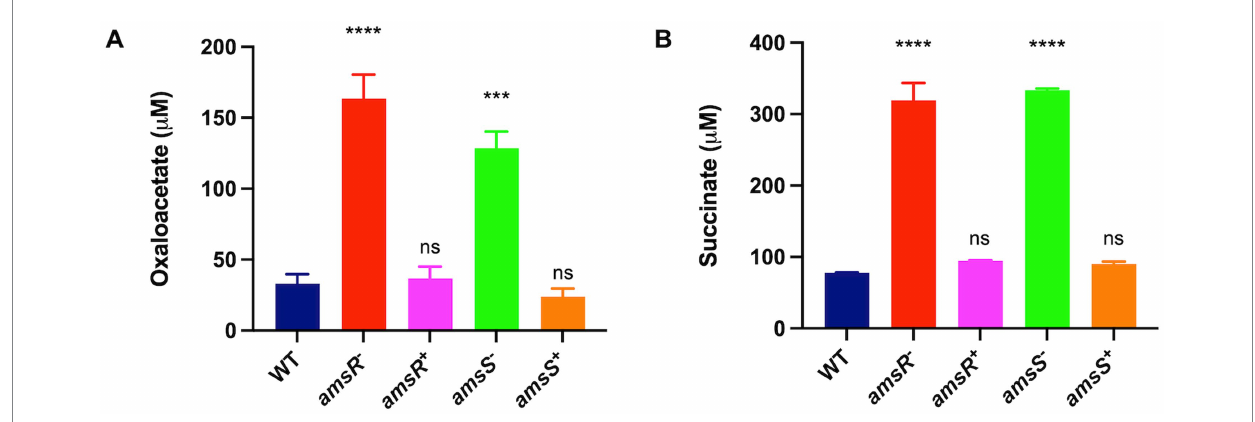
FIGURE 8 Oxaloacetate and succinate accumulate in amsSR mutants due to impaired TCA cycle activity. The concentration of oxaloacetate (A) or succinate (B) was measured in exponentially growing cells. Data is derived from three independent biological replicates. Error bars ± SEM. One-way analysis of variance, with Dunnett’s multiple-comparisons test, was used to assess statistical significance in comparison to wild-type, *** p < 0.001, **** p < 0.0001, ns, not significant.